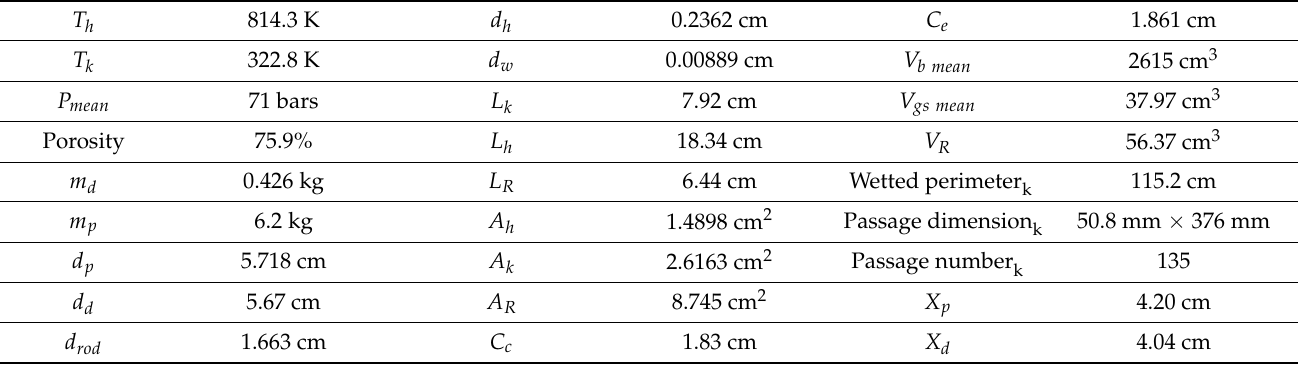
Table 2. FPSE input parameters [15].